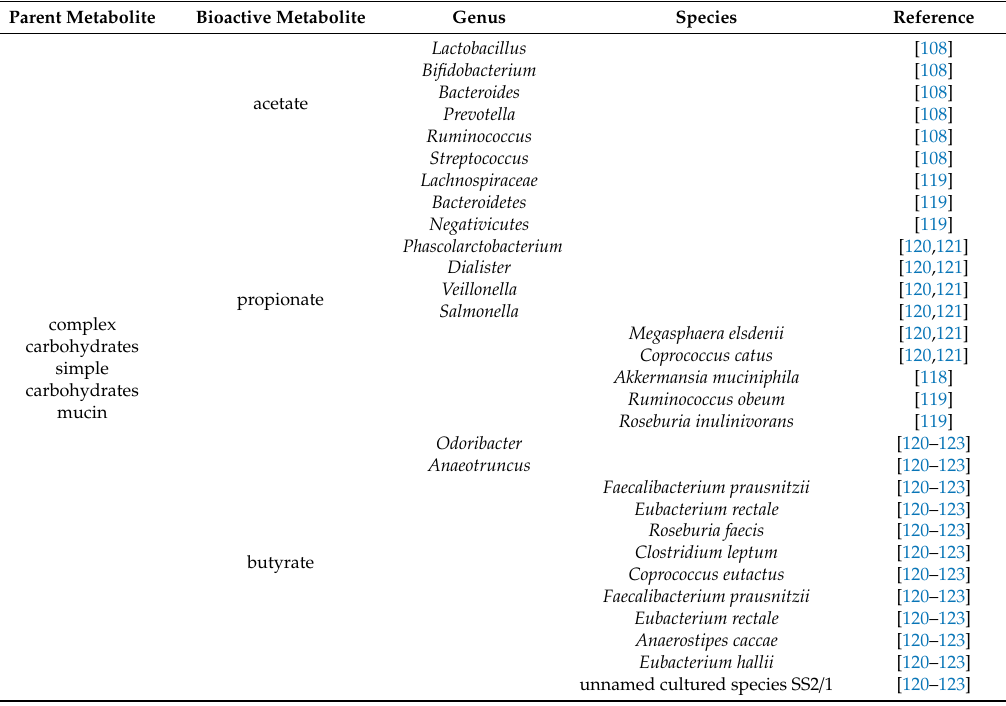
Table 2. The microbial source of the metabolites mentioned in the